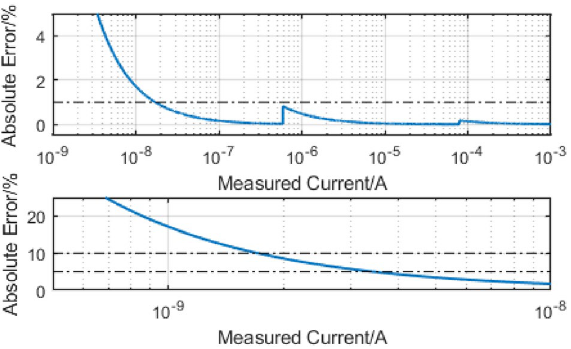
Figure 6. Graph showing predicted absolute error based on 3 σ current noise